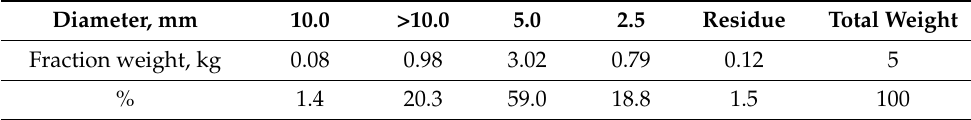
Table 1. Granulometric composition of expanded clay gravel.